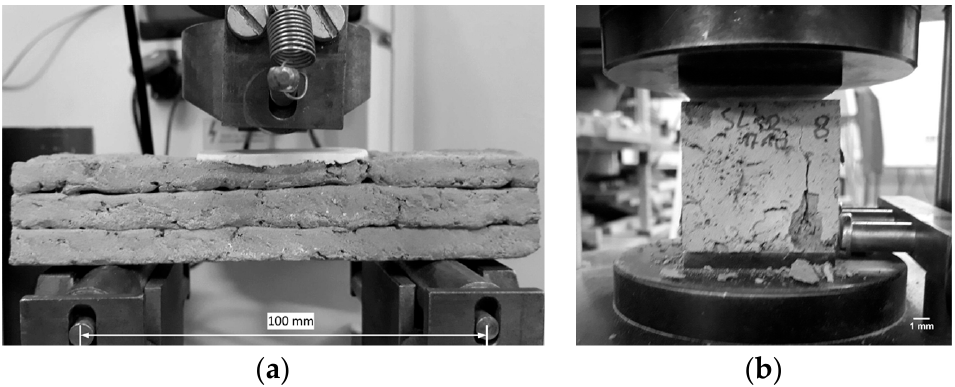
Figure 5. Measurement of the mechanical properties of the printed specimens: ( a ) three-point bending test (Zwick 1445, ZwickRoell GmbH & Co. KG, Ulm, Germany), ( b ) uniaxial compression test (EU20, VEB Werkstoffprüfmaschinen, Leipzig, Germany).